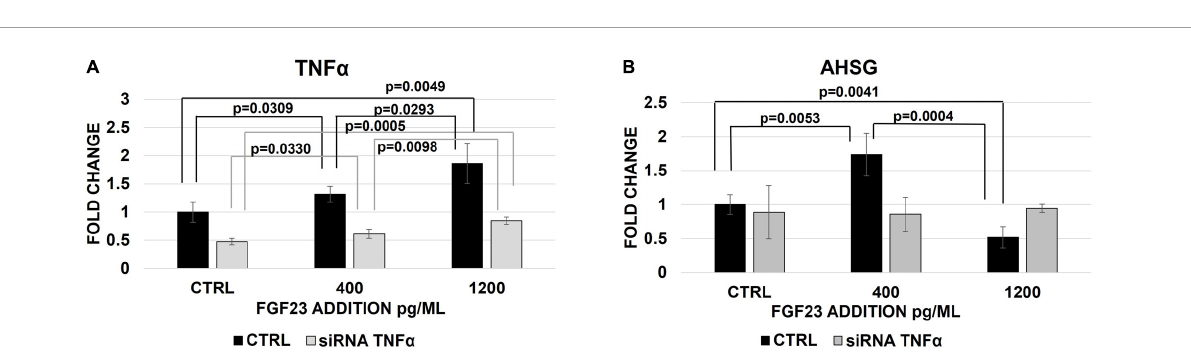
FIGURE5 Changes of TNF α (A) and AHSG (B) mRNA expression 30 h after the treatment with non-targeted siRNA (CTRL) or TNF α silencing and 24 h after the exposure to 400 and 1,200 pg/ml of FGF23 in HepG2. N =